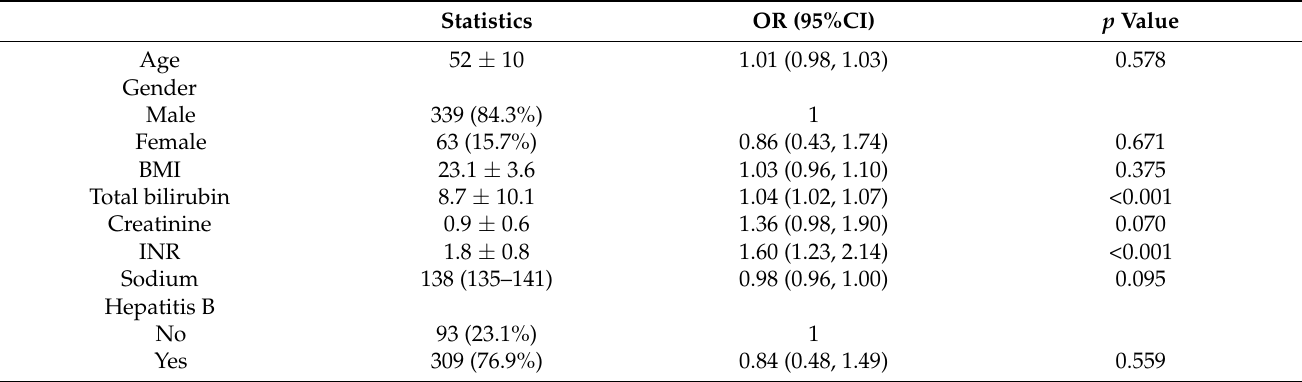
Table 2. Predictors of post-transplant delirium by univariate